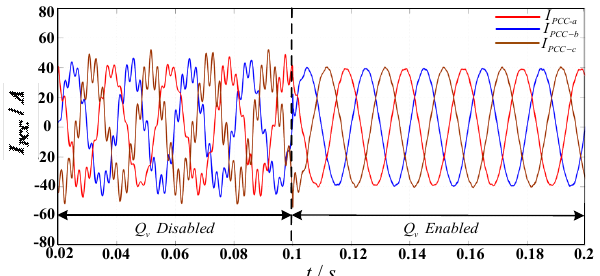
Figure 21. Simulation result of current waveform at PCC after injecting 5th and 7th harmonic voltage.